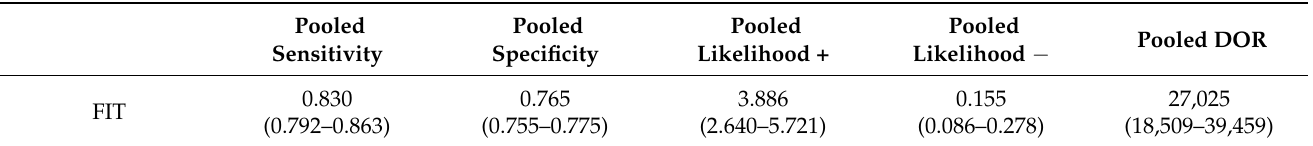
Table 3. The pooled sensitivity, specificity, positive and negative likelihood ratio for the FIT for patients with symptoms.